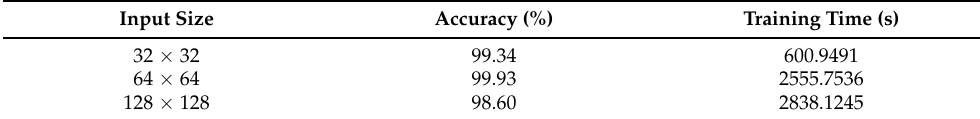
Table 4. Accuracy at different input sizes I [ B = 32, R = 0.0001, θ = Adam].